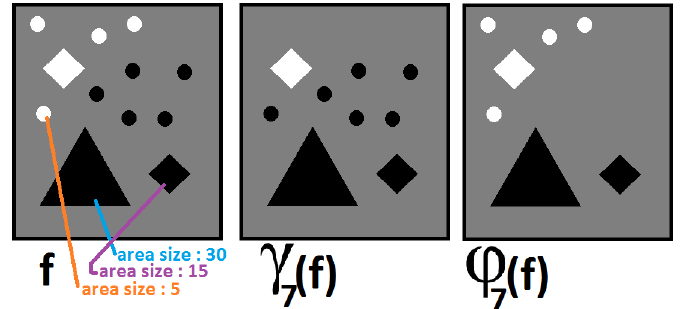
and an area closing φ a s of image f , with s l = 7 pixels. l l